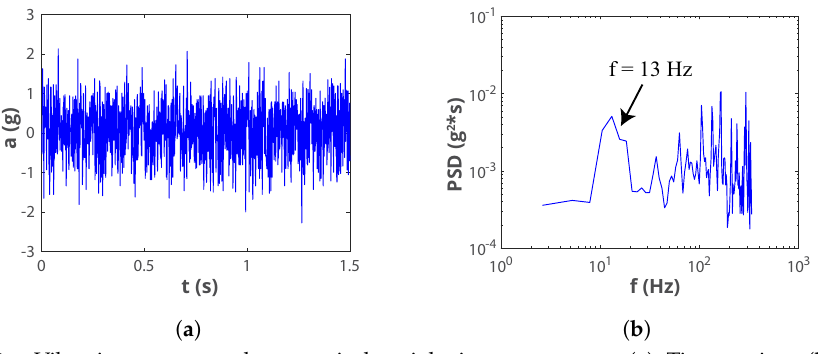
Vibrations measured on an industrial air compressor: ( a ) Time series; ( b ) Power spectral